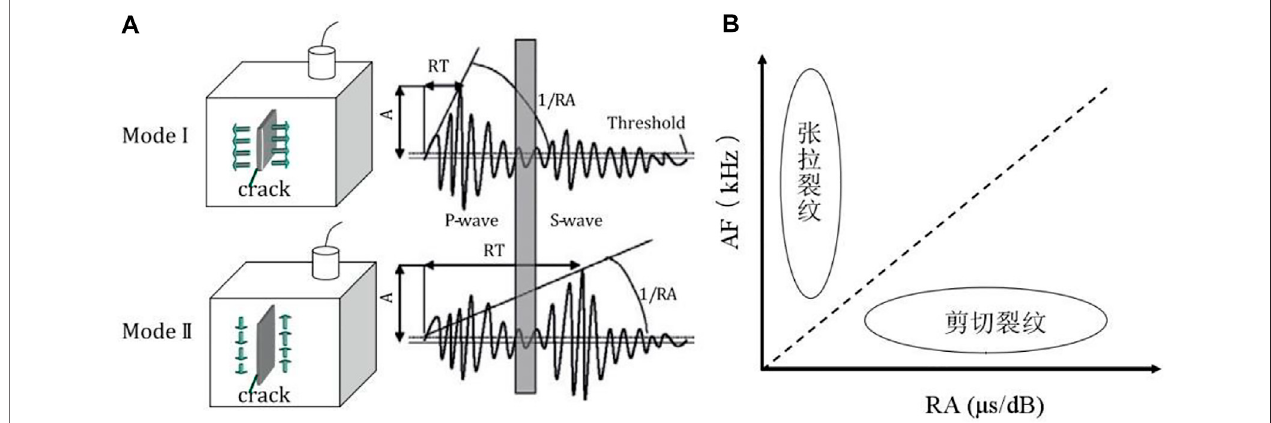
FIGURE11| Schematicdiagramofidentifyingfracturemodebythewaveformparametermethod. (A) FracturemodeandAEwaveform(D.G.Aggelisetal.,2012); (B) relationship between the AF and RA value (Ohno K., 2010).